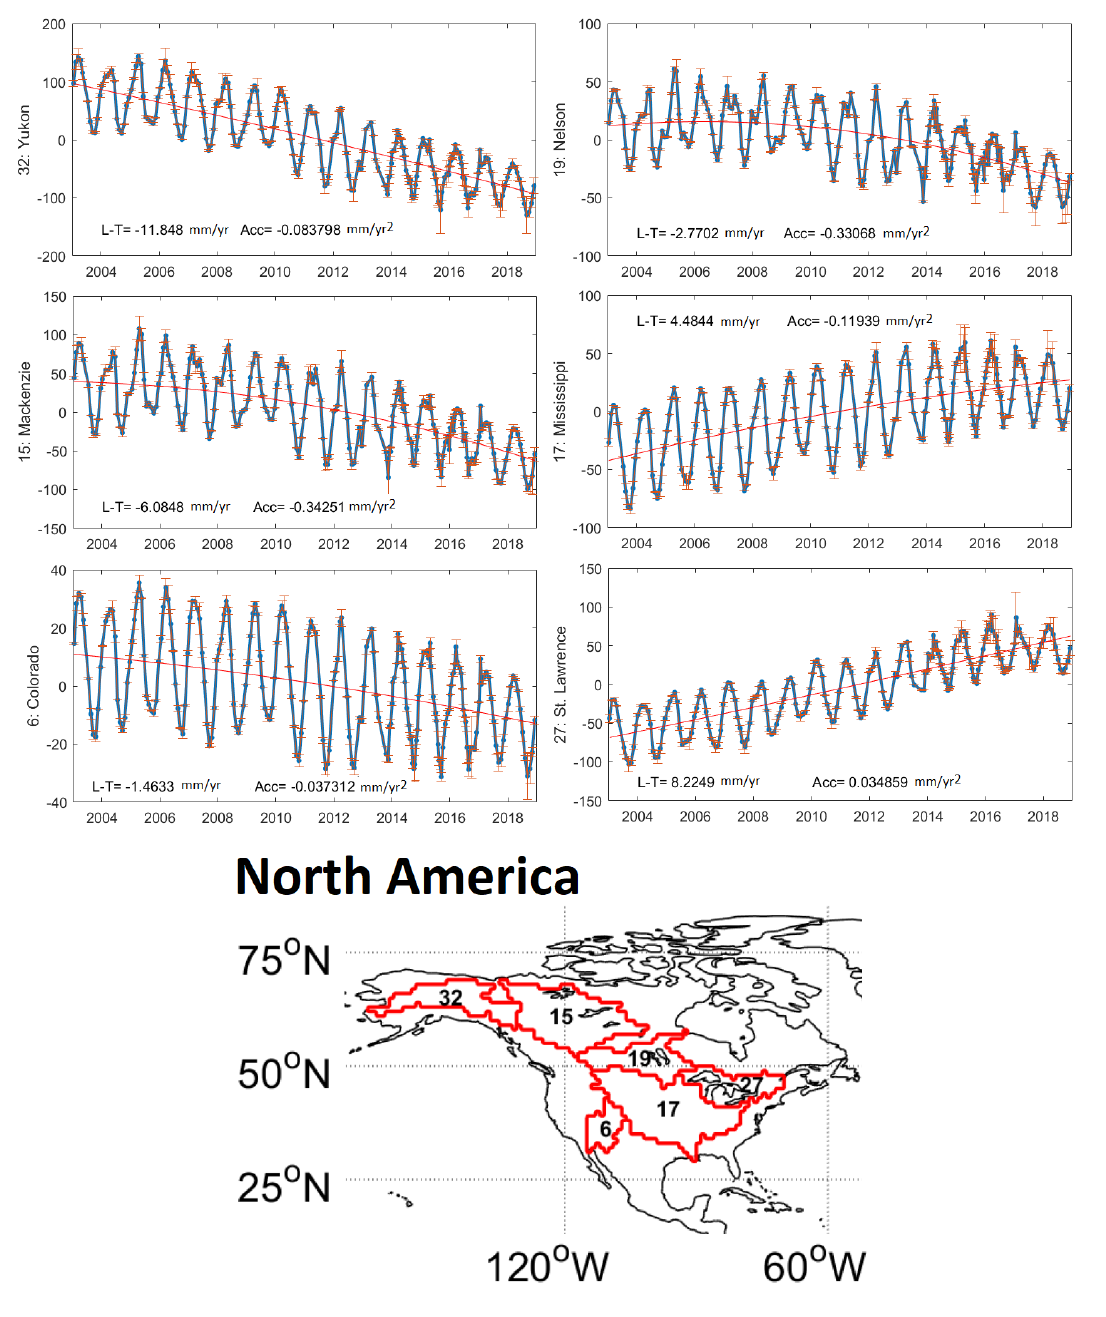
Figure 6. Basin averages of the reconstructed TWSC estimates within the six major river basins of North America, covering 2003–2018. The red lines show the long-term linear trend and acceleration component fitted to the basin-averaged TWSC estimates using the least squares approach. Note that the values of linear trend (mm/yr) and acceleration (mm/yr 2 ) components fitted to each time series are shown by L-T and Acc,